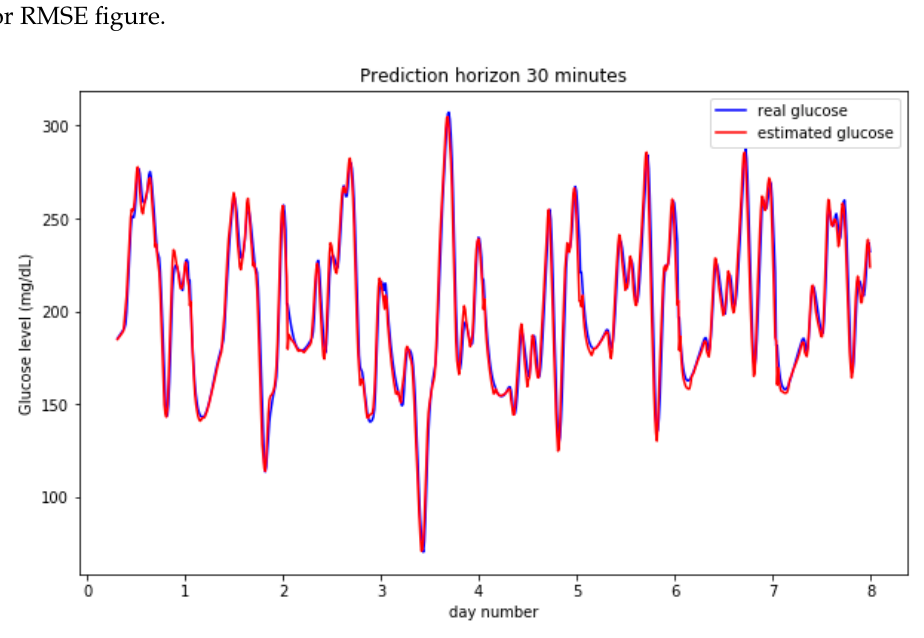
Figure 2. Predictions on a 30 min horizon for 8 days for a simulated participant. Sensors 2020 , 20 , x FOR PEER REVIEW